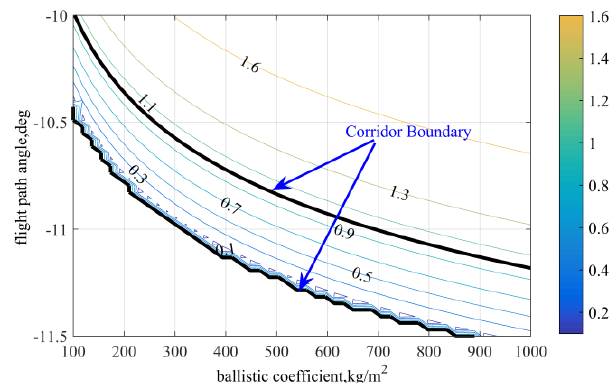
Figure 3. The aerocapture corridor under pure drag modulation.